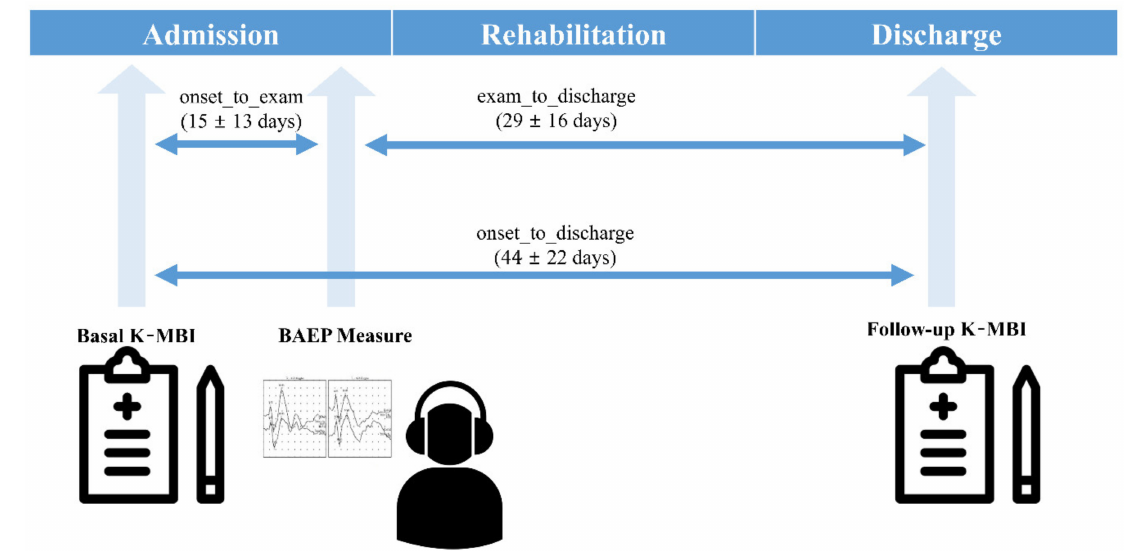
Figure 1. Protocol of the present